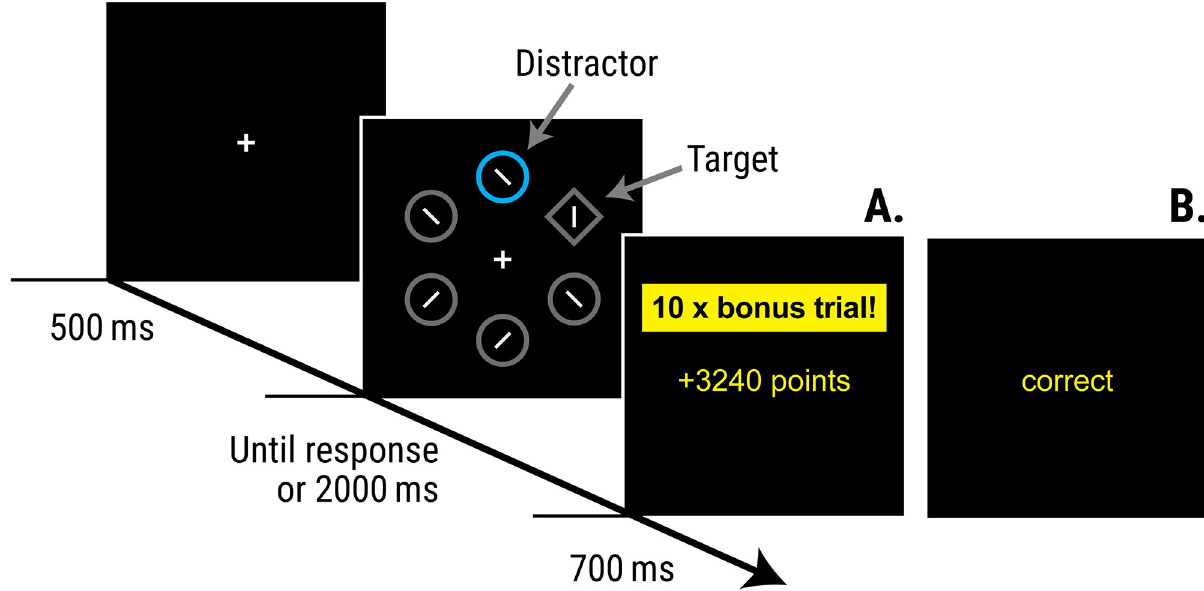
Fig 1. Trial structure of the VMAC task. Participants had to respond to the orientation of the line segment within the diamond (target); on the majority of trials, one of the circles in the display was a colour-singleton distractor. Only the feedback screens differed between phases of the procedure. During the reward phase (A) faster responses earned more points and the colour of the distractor signalled whether or not these points would be multiplied by 10 (bonus trials, as depicted here). During the unrewarded test phase (B) feedback simply informed participants whether or not they had responded